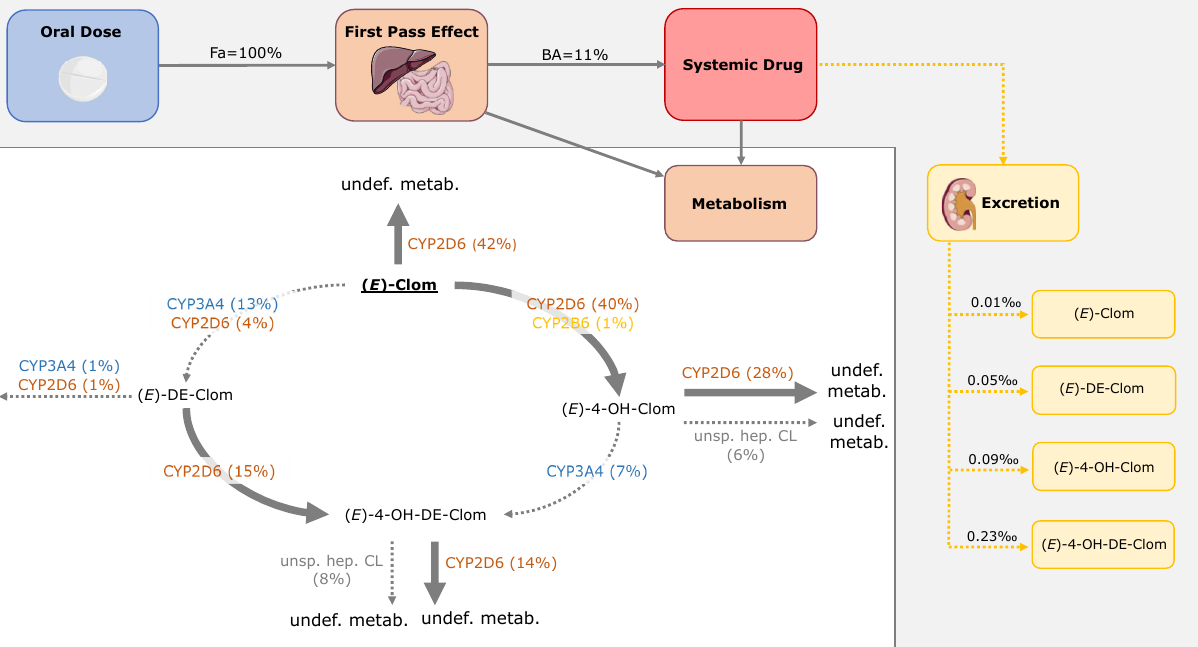
Figure 9. Mass balance diagram after oral administration of 62 mg ( E )-Clom citrate in CYP2D6 normal metabolizers (AS = 2) including fraction absorbed, bioavailability and fractions of dose excreted in urine for ( E )-Clom and the three implemented metabolites. Drawings by Servier, licensed